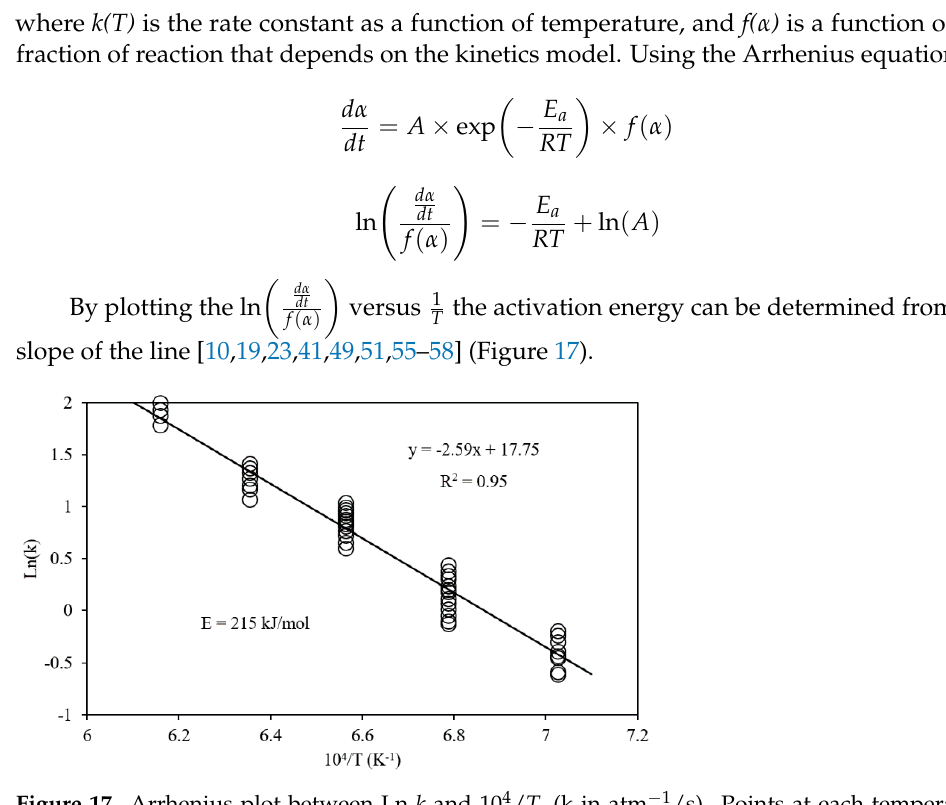
Figure 17. Arrhenius plot between Ln k and 10 4 / T . (k in atm − 1 /s). Points at each temperature represent data under different H 2 partial pressures and reaction times [48] “modified”.